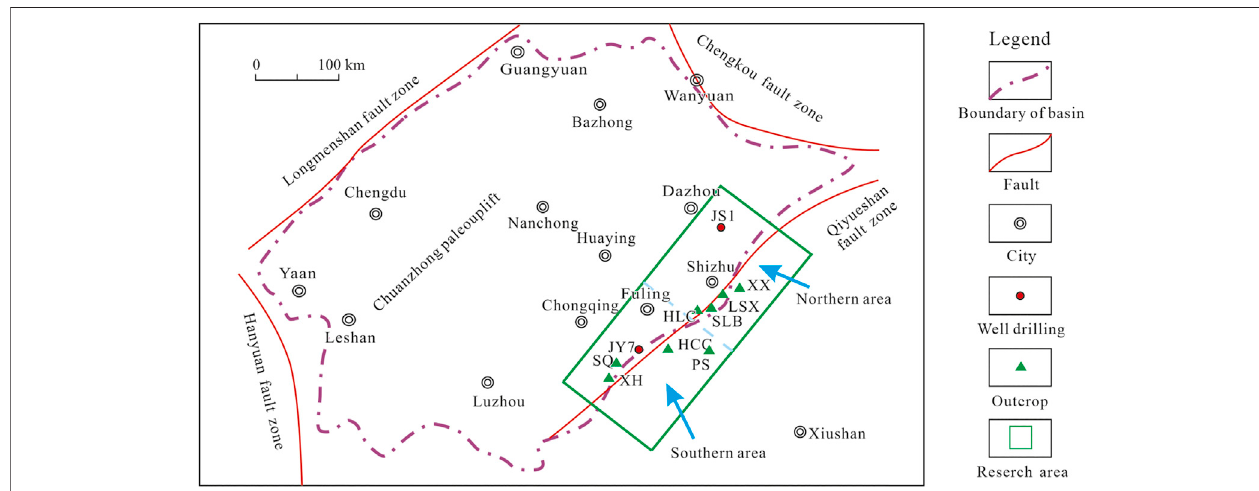
FIGURE 1 | Tectonic position of the study area.